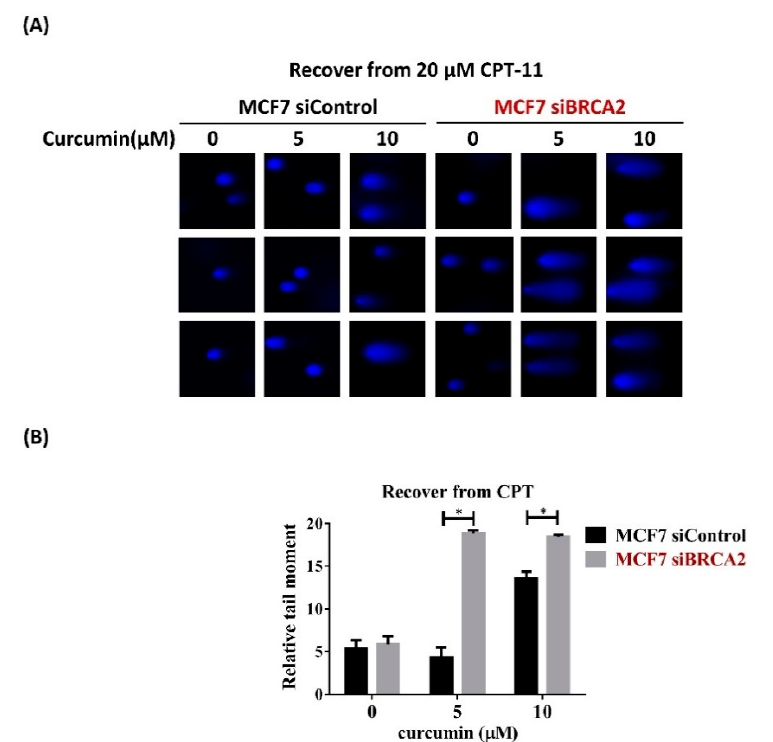
Figure 4. Curcumin reduced HR to sensitize BRCA2-deficient cells to chemotherapy. Curcumin inhibited DNA repair following CPT-11 treatment in MCF7-siBRCA2 cells. ( A ) The cells were treated with CPT-11 to induce DSBs for 1 h; then, CPT-11 was washed out, and the cells were allowed to recover in media containing curcumin for 4 h. The samples were analyzed by comet assay. ( B ) Quantification of the tail moment of over 50 cells from A by open comet. Error bars represent the standard deviations of at least 3 independent experiments. Asterisks (*) indicate signifi- cant differences between CPT-11 and combined CPT-11 and curcumin cells (* p < 0.05).